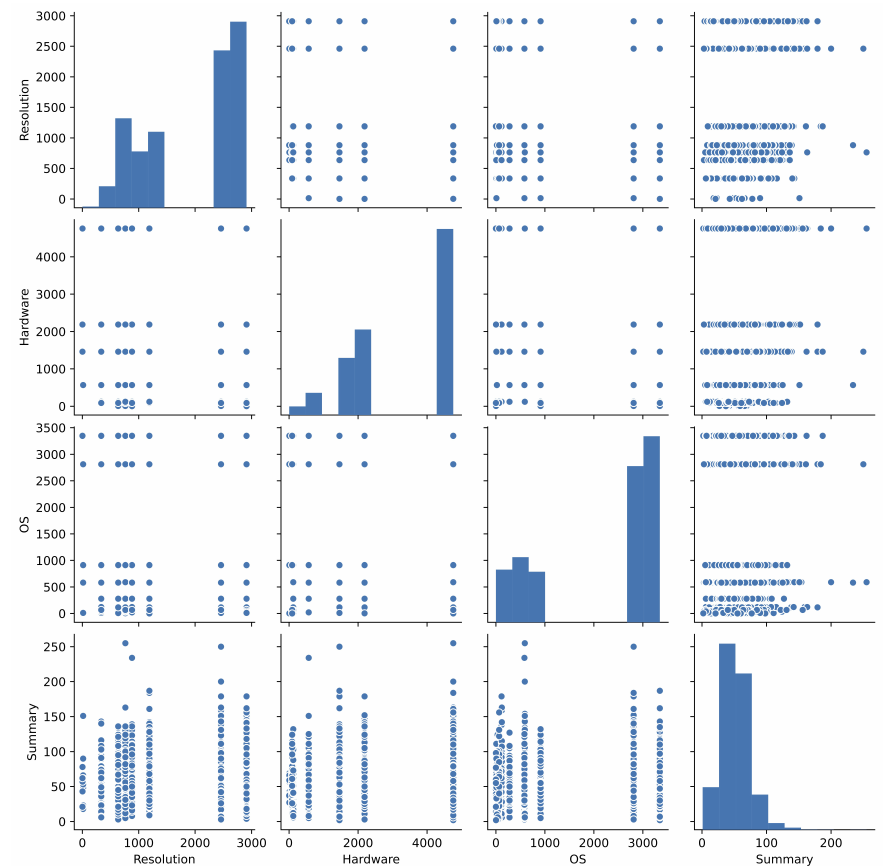
Figure 4. The pairplot for actual fault big data